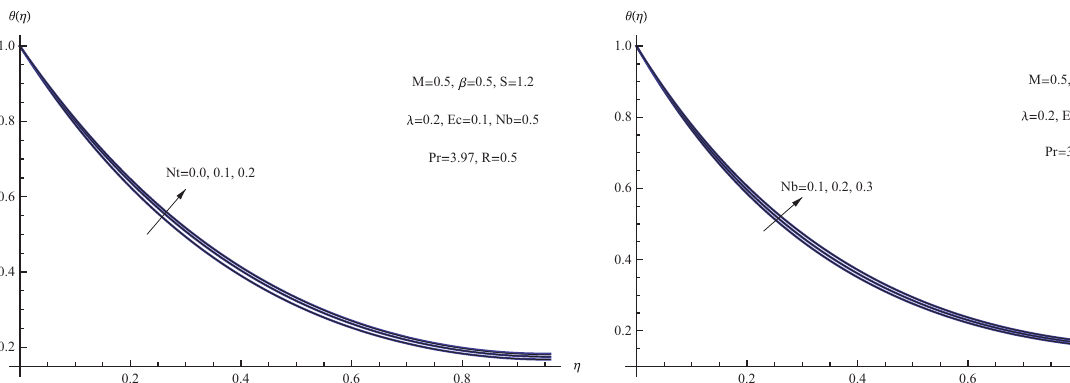
Figure 16: ( ) θ η for assorted quantities of Nt.